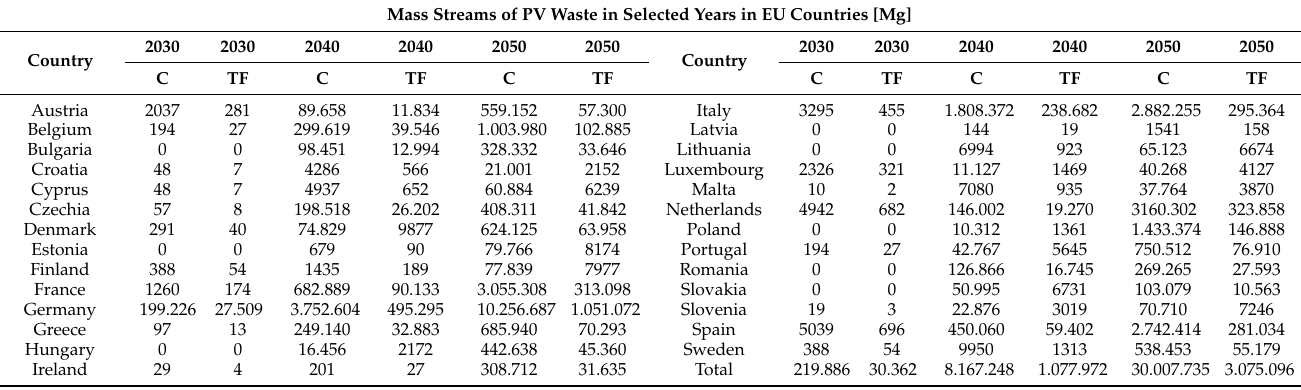
Table 7. Cumulated mass streams of PV waste in European